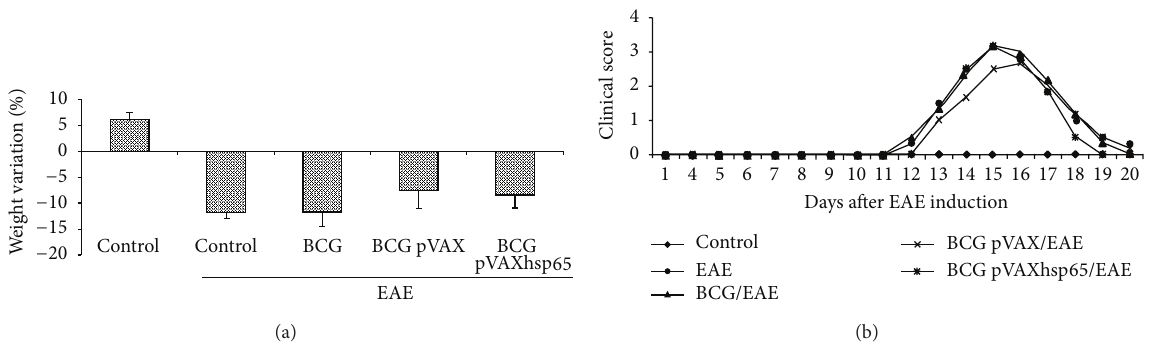
Figure 1: Effect of previous immunization with BCG and BCG/pVAXhsp65 in clinical EAE development. Female Lewis rats were immunized with BCG alone or with BCG followed by pVAXhsp65 boosters and then underwent EAE induction by inoculation of MBP emulsified with CFA. Animals were daily evaluated for weight variation (a) and clinical score (b). Data are presented by mean ± SEM for 4–6